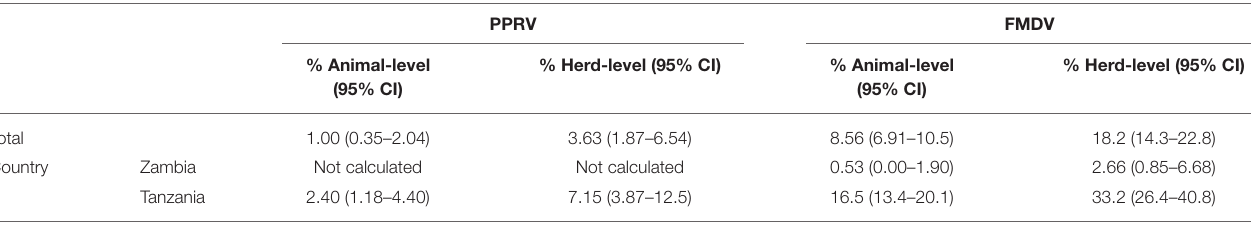
TABLE 7 | True animal- and herd-level seroprevalence for PPRV and FMDV.